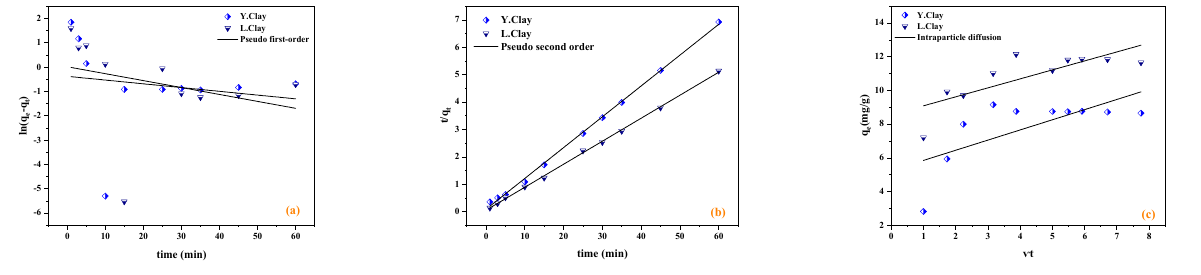
Figure 9. ( a ) pseudo-first-order, ( b ) pseudo-second-order, ( c ) intraparticle diffusion Kinetic models plot. Table 3. Kinetics parameters of each tested model for adsorption of crystal Violet Dye. Adsorbents q e (mg/g)